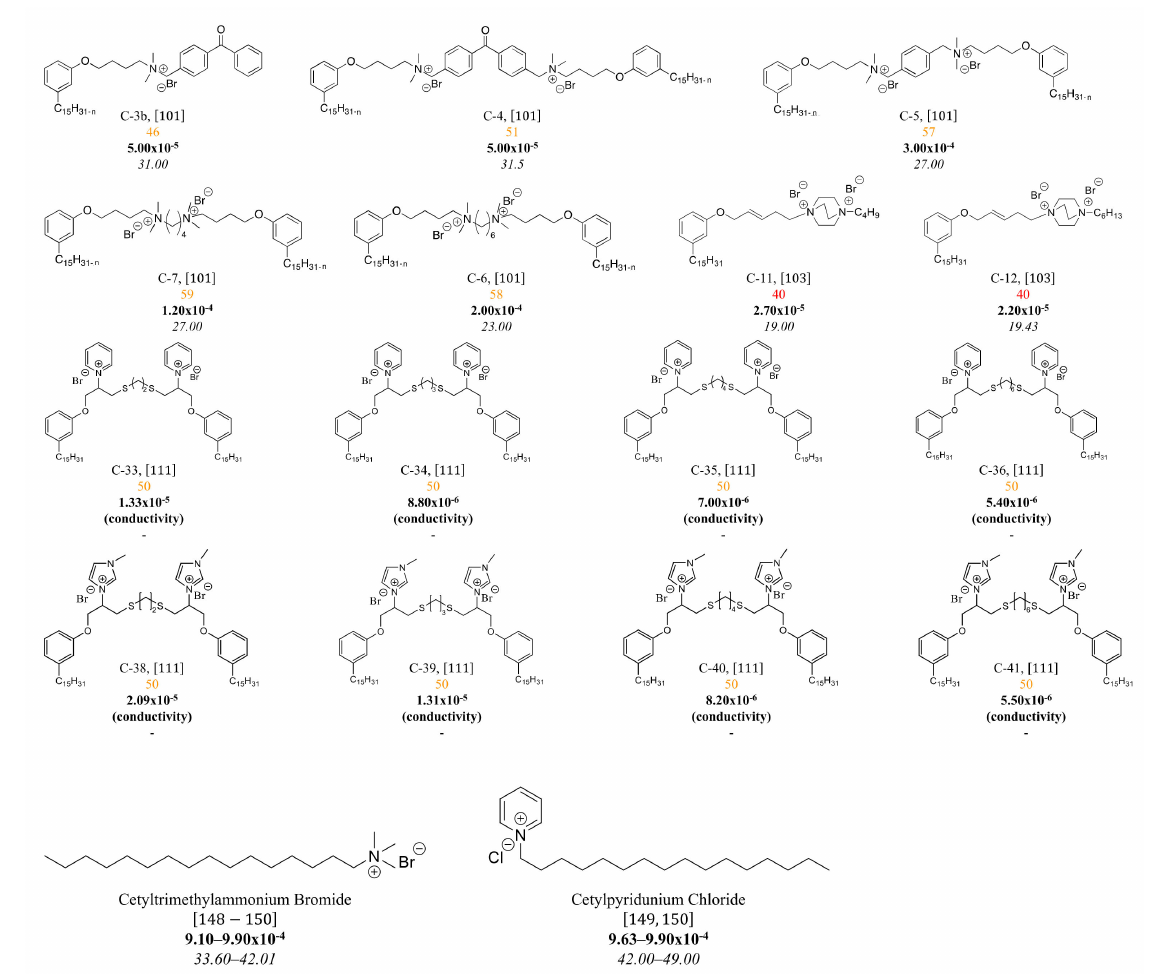
Figure 17. % bio (red for % under 50% and orange in between (50–75%), CMC (mol/L, bold) and surface tension (mN/m, italics) of cationic Gemini CNSL-based surfactants, single chain analog and commercial